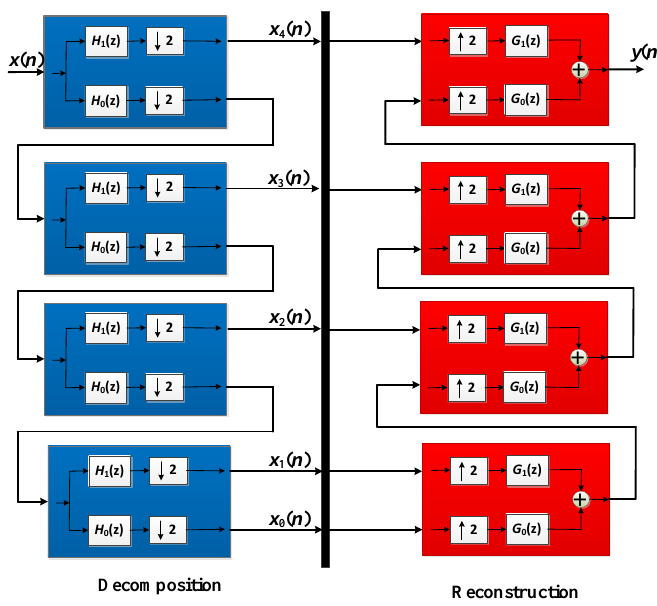
Figure 20. Principle of four-level Haar wavelet decomposition and reconstruction. H 0 represents low pass filter of the Haar wavelet decomposition; H 1 represents high pass filter of the Haar wavelet decomposition; G 0 represents low pass filter of the Haar wavelet reconstruction; G 1 represents high pass filter of the Haar wavelet reconstruction.